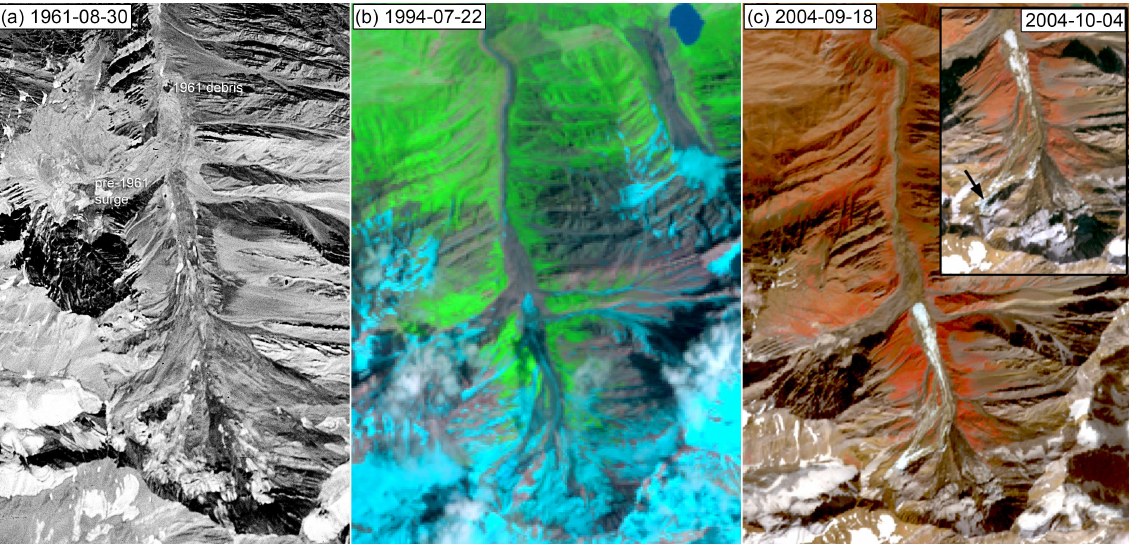
Figure A2. (a) The KH-3 image from 30 August 1961 shows strong erosion in the entire Shuraki Kapali catchment. (b, c) Mass flow events in the western sub-catchment. (b) L5 image of the sk-94 rock-ice avalanche (22 July 1994). (c) ASTER image of the sk-04 detachment (18 September 2004) followed by an ice avalanche (inset: 4 October 2004). Imagery courtesy of the US Geological